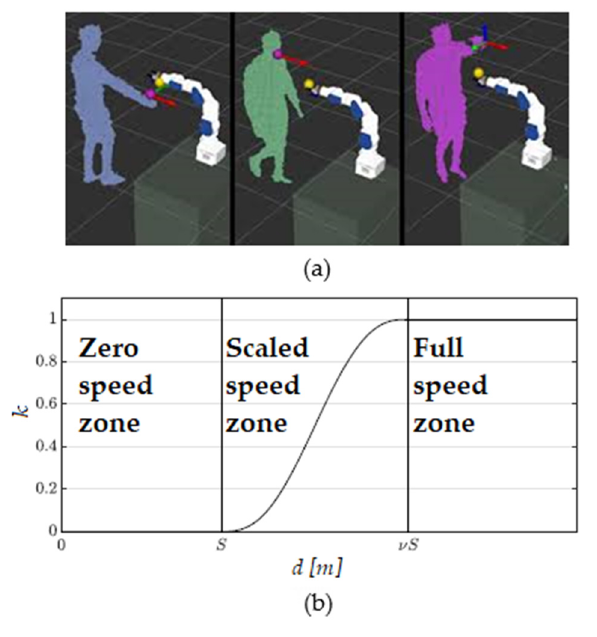
Figure 2. ( a ) Human-hand detection by robot sensors and cameras; ( b ) trend of normalized robot speed in proximity of human (plot courtesy of [37]).